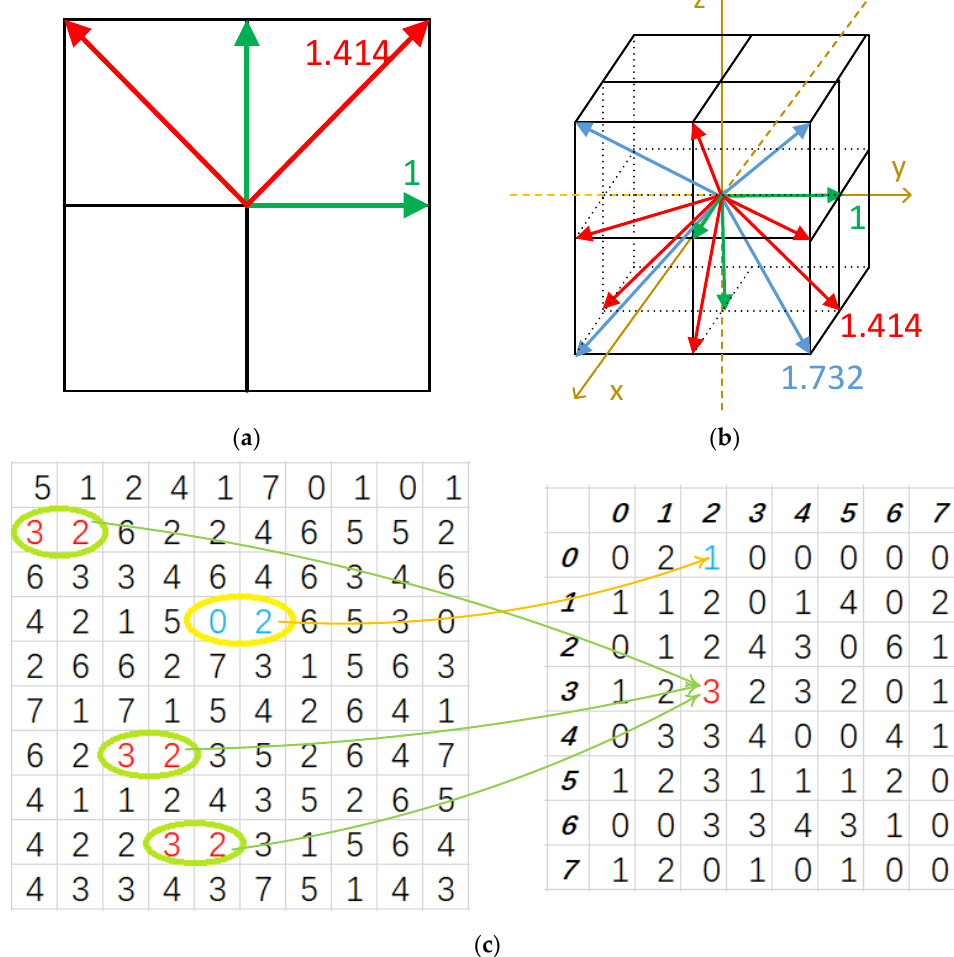
Figure 1. Illustration of co-occurrence matrix (CM) calculation in 2D/3D images: ( a ) CM parameters in 2D images; ( b ) CM parameters in 3D images; and ( c ) A GLCM example of a 2D case when direction is 0° and displacement = 1. The left is a gray image, and the right one is its GLCM. In a digital image array, the first- and second-order neighbors, which comprise the first ring around the center image voxel, are most frequently used for vector calculation.